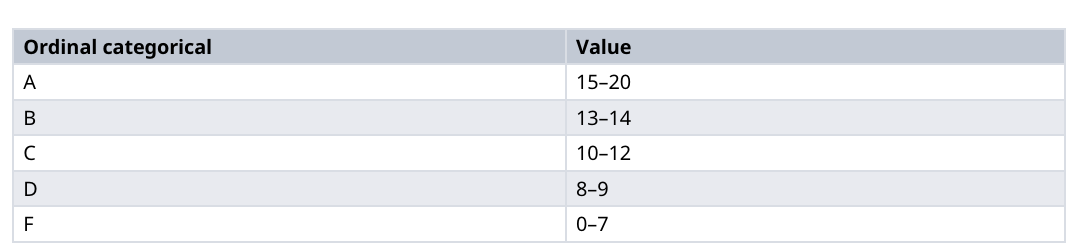
Table 5. 5 Levels classification.